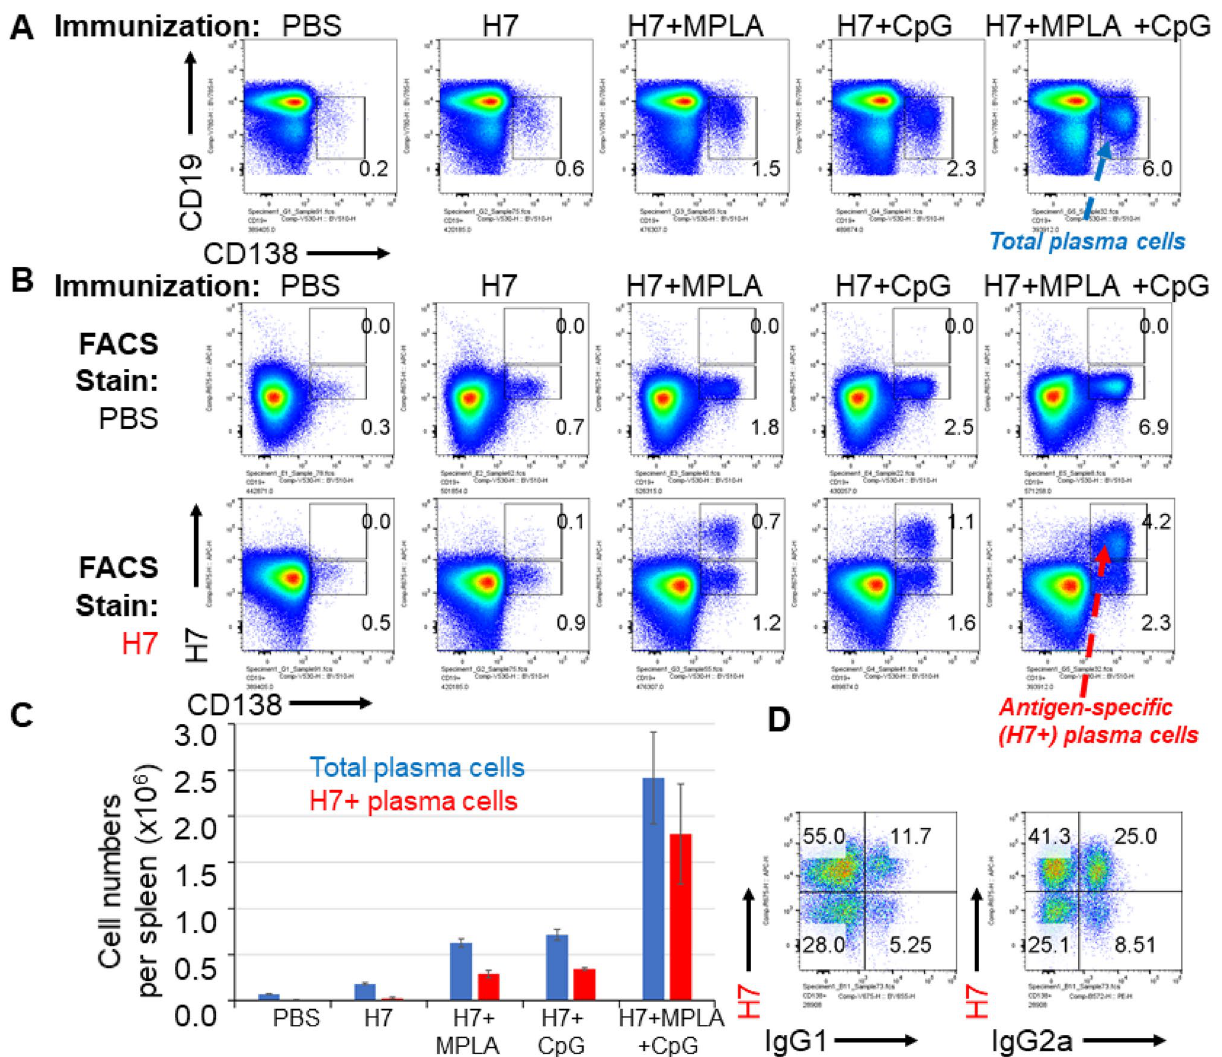
Figure 6. MPLA and CpG synergize to induce HA-specific plasma cell formation in vivo. Mice were immunized on day 0 with PBS (control), or influenza virus HA (H7 from A/Anhui/1/2013) alone or with MPLA, CpG or MPLA/CpG, all in the presence of AddaVax. Mice were boosted i.p. on day 14, and spleens harvested on day 19. ( A ) Plasma cells, defined as CD138 + , CD19lo; ( B ) antigen-specific plasma cells; ( C ) numbers of total (blue) and antigen-specific (red) plasma cells; ( D ) total plasma cells, defined as CD19lo CD138+ as in ( A ) above, are plotted to visualize H7 fluorescence vs IgG1 or IgG2a expression. H7-specific plasma cells induced by immunization with IVAX1 produce predominantly Th1-associated